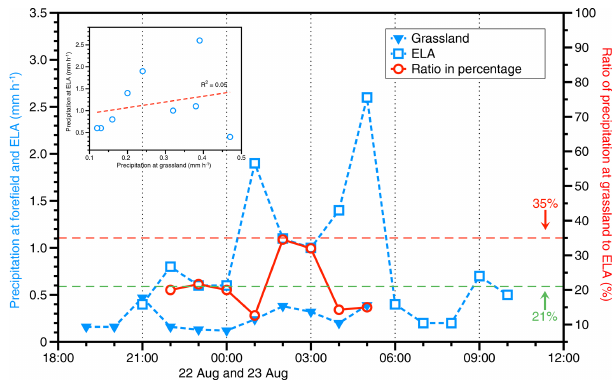
Figure 6. The precipitation recorded by the AWSs at grassland (in- verse blue solid triangles) and ELA (hollow blue squares), and the precipitation record ratio of grassland to ELA (hollow red circles) during 22–23 August, in which the scatterplot of the precipitation from both AWSs is included. The green and red dashed lines indi- cate the upper limit and mean of the